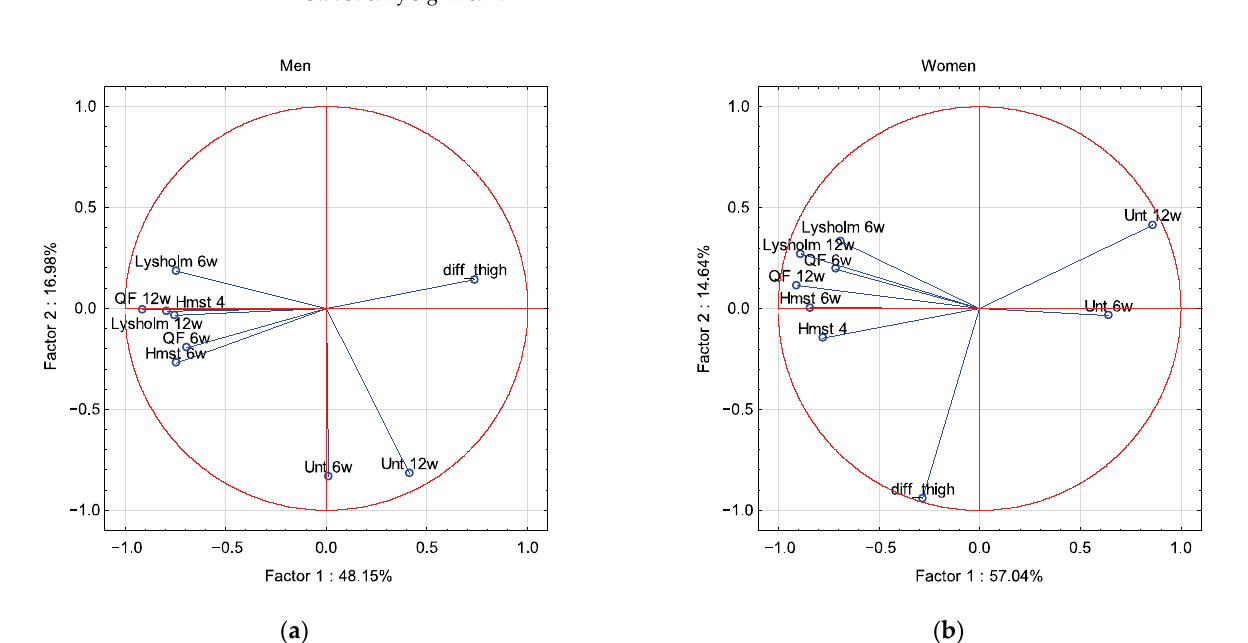
Figure 2. A graphic illustration of Principal Components Analysis of Lysholm, Unterberger test and muscle strength. Projection of the variables on the factor plane of the first two principal components for the men ( a ) and women ( b ).